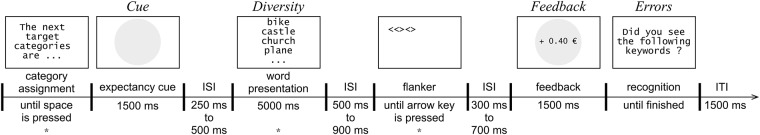
Trial structure, Study 2.The structure was similar to Study 1; asterisks mark the three phases in which the design differed from the first study. The differences were: 1) multiple categories were assigned 2) 12 words were presented, for a longer time, always using the same layout and 3) the flanker was displayed in a randomly selected quarter of the screen. This design was nearly identical to that employed in Study 3, which differed only in the arrangement of keywords. Above each phase, variable names of interest are indicated in italics.